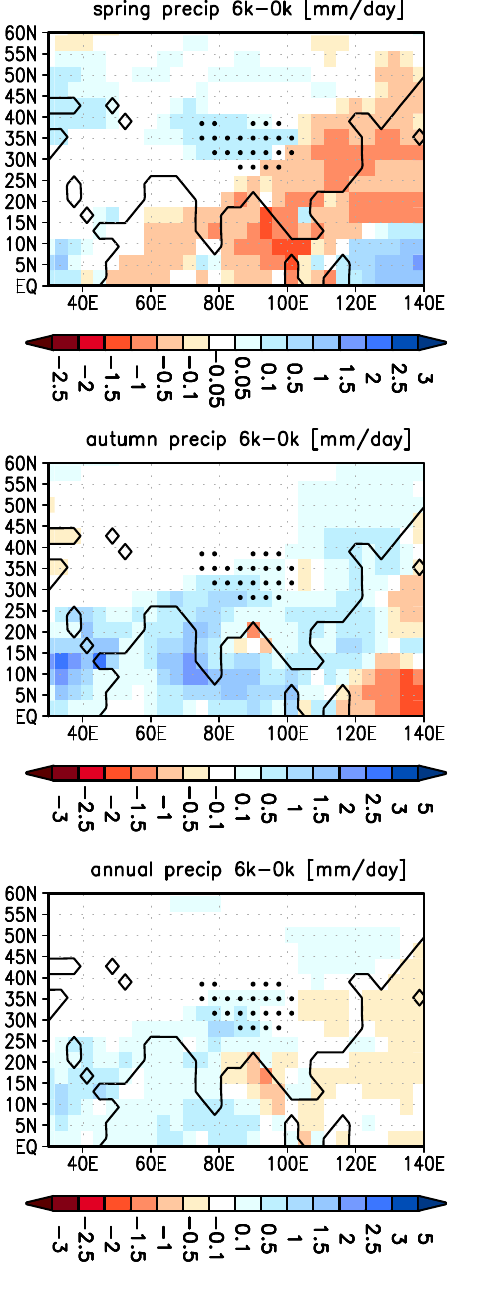
Fig. 3. Same as Fig. 2, but for seasonal and annual averaged precipitation anomalies [mm/day]. It has to be emphasized that, due to the differences in the length of the respective seasons between mid-Holocene (6k) and present-day (0k) climate, a higher precipitation rate per day does not necessarily indicate a higher seasonal sum, i.e. a higher amount of precipitation per season. Please note differences in colour